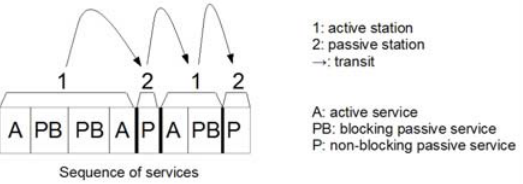
Figure 5: Service grouping for